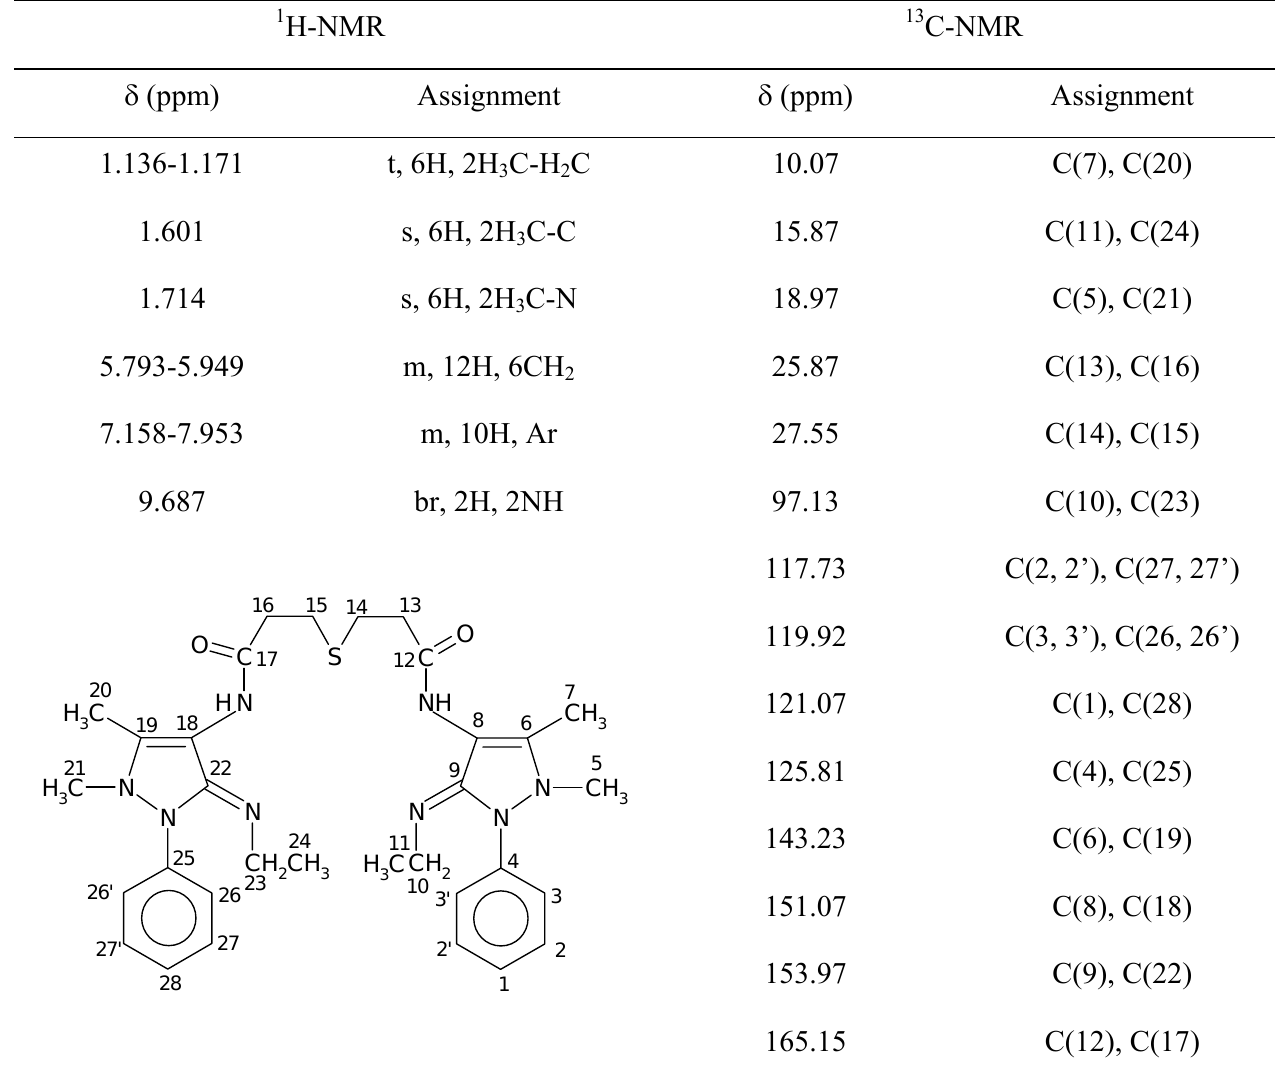
Table 2. The NMR data of the Schiff’s base ligand. 1 H-NMR 13